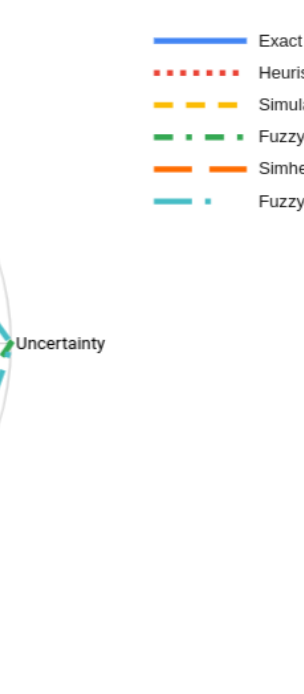
Figure 1. A comparison of different solving approaches while using key